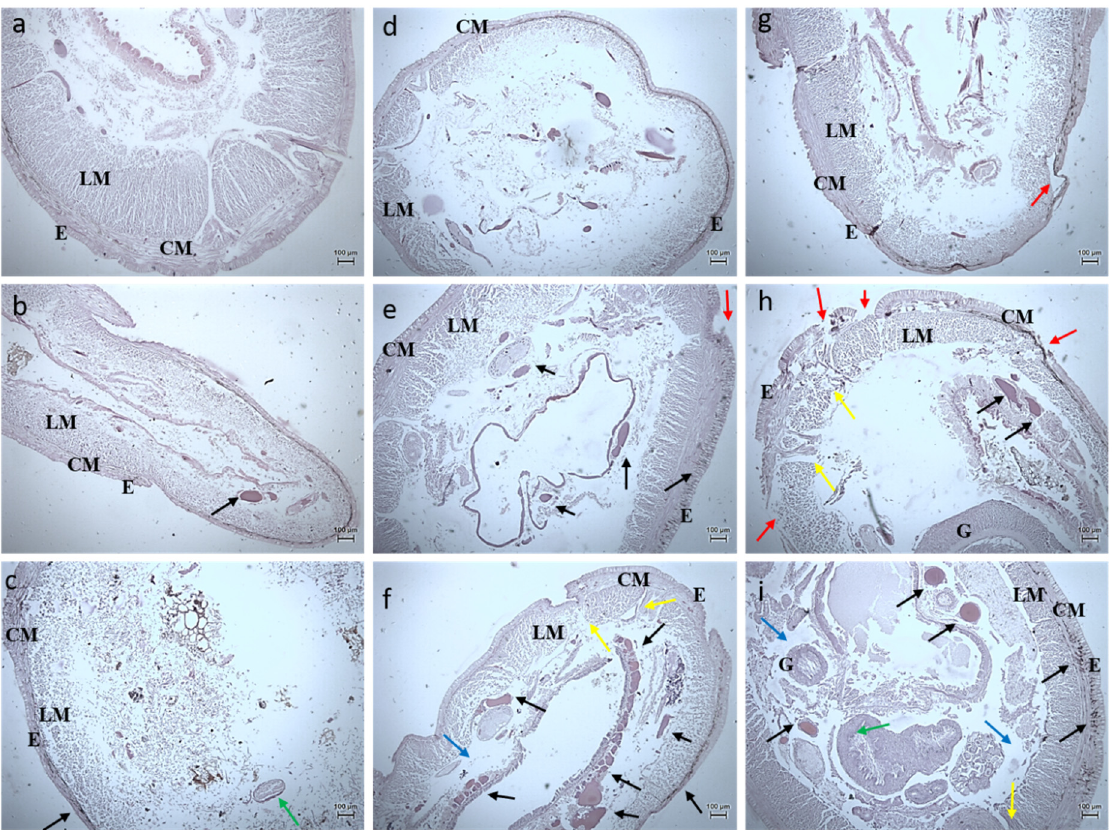
Figure 12. Histology images of midgut region of earthworm— Eudrilus eugeniae (10X Magnification) ( a ) 10th day control, ( b ) exposed to 10 µg at 10th day, ( c ) exposed to 20 µg at 10th day; ( d ) 20th day control, ( e ) exposed to 10 µg at 20th day, ( f ) exposed to 20 µg at 20th day; ( g ) 30th day control, ( h ) exposed to 10 µg at 30th day, ( i ) exposed to 20 µg at 30th day. G—Gut, E—Epidermis, LM—Longitudinal Muscle, CM—Circular Muscle. Black arrow denotes lipofuscin, red arrow denotes erosion of epidermis, blue arrow denotes interstitial space, yellow arrow denotes fibrosis of CM, green denotes arrow disruption of gut.